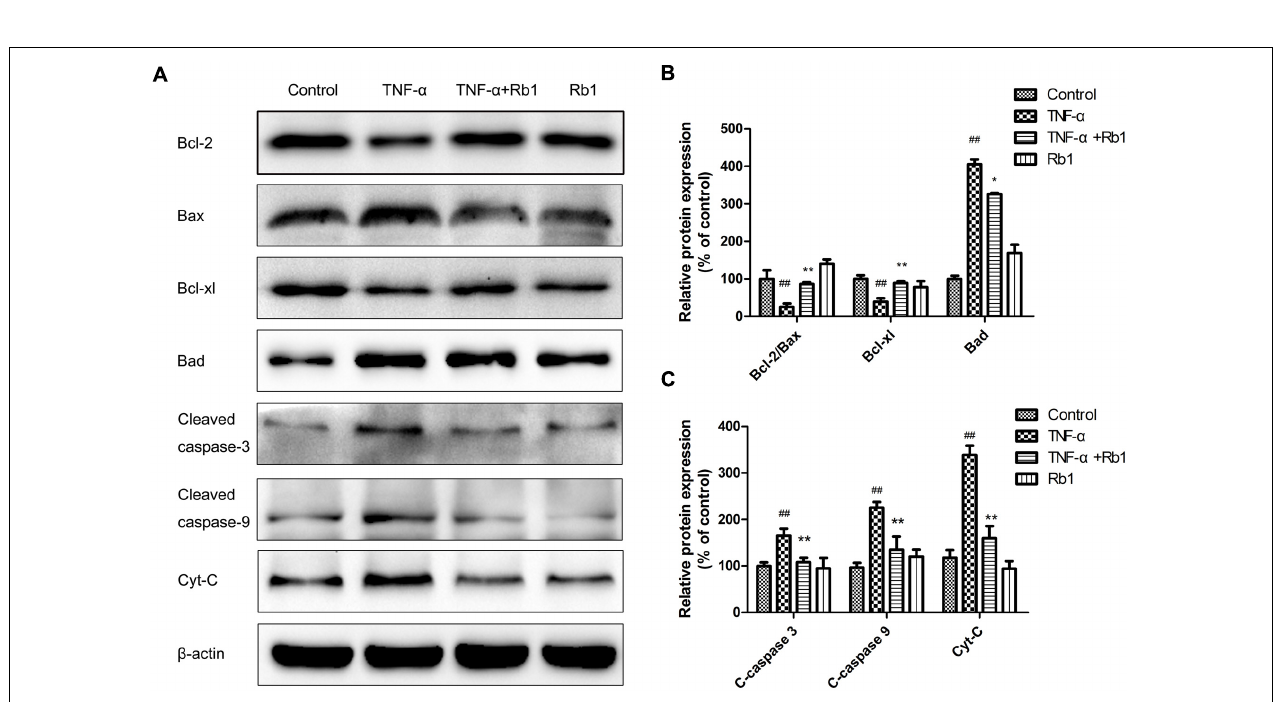
FIGURE 5 | Effects of ginsenoside Rb1 on apoptosis-related protein expression in TNF- α -treated HUVECs. HUVECs were exposed to TNF- α for 24 h after incubation with ginsenoside Rb1 (20 µ g/mL) for 8 h. (A) The levels of Bcl-2/Bax, Bcl-xl/Bad, cleaved caspase-9 and cleaved caspase-3 were determined by western blot. (B) Quantitative analysis of Bcl-2/Bax expression ratio and Bcl-xl and Bad expression levels. (C) Quantitative analysis of cleaved caspase-3, cleaved caspase-9, and Cyt-c expression. Data were expressed as the mean ± SD of three independent experiments. ## P < 0.01 vs. control group; ∗ P < 0.05, ∗∗ P < 0.01 vs. TNF- α treatment